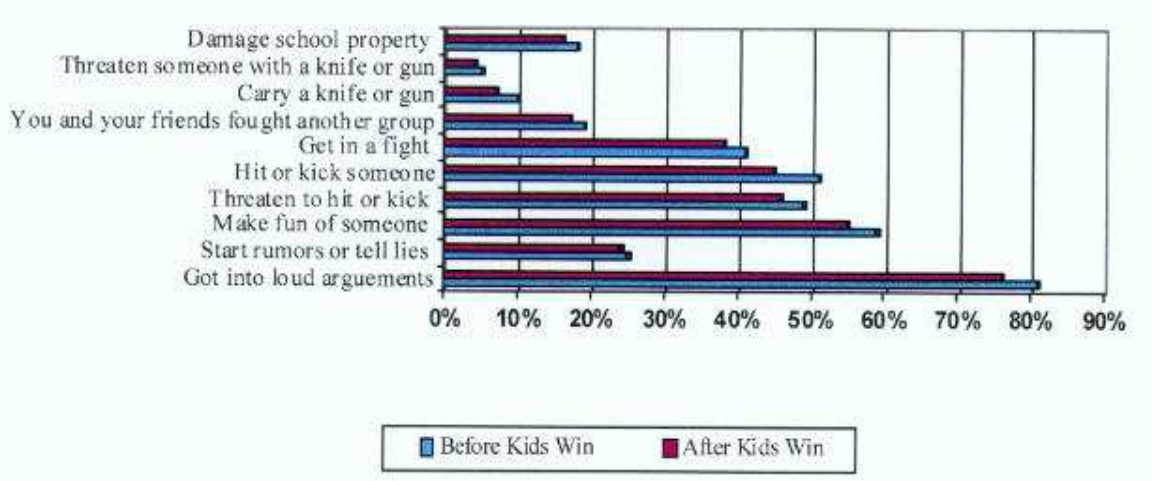
Comparison of Percent of Students Engaging